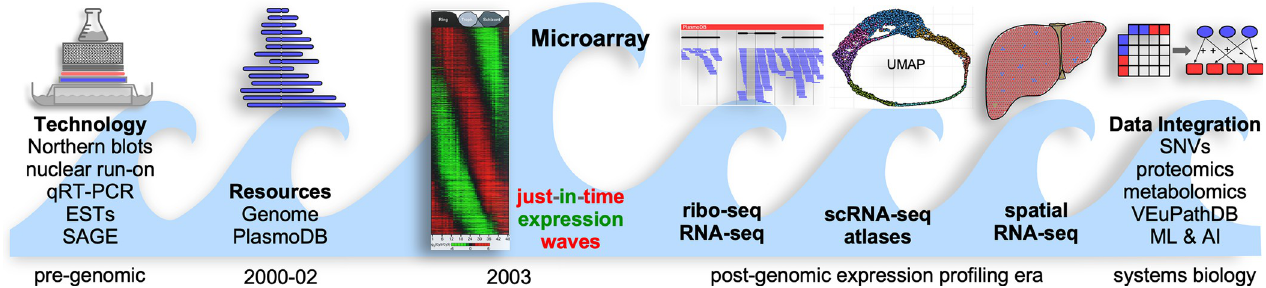
Fig 1. The evolution of parasite transcriptomics. The advent of the expression microarray was a transformative event that for the first time revealed dynamic, genome-wide expression changes. Over time, in the postgenomic era, this has become more refined in spatiotemporal resolution. The next wave of systems biology requires new computational tools that are expected to reveal new aspects of parasite biology for translation. Adapted from [1]. AI AU : AnabbreviationlisthasbeencompiledforthoseusedinFig 1 ; attheendofthefigurecaption : Pleaseverifythatallentriesarecorrectlyabbreviated : , artificial intelligence; EST, expressed sequence tag; ML, machine learning; qRT-PCR, quantitative reverse transcription PCR; ribo-seq, ribosome sequencing; RNA-Seq, RNA sequencing; SAGE, Serial Analysis of Gene Expression; scRNA-seq, single-cell RNA sequencing; SNV, single-nucleotide variation; UMAP, Uniform Manifold Approximation and Projection.